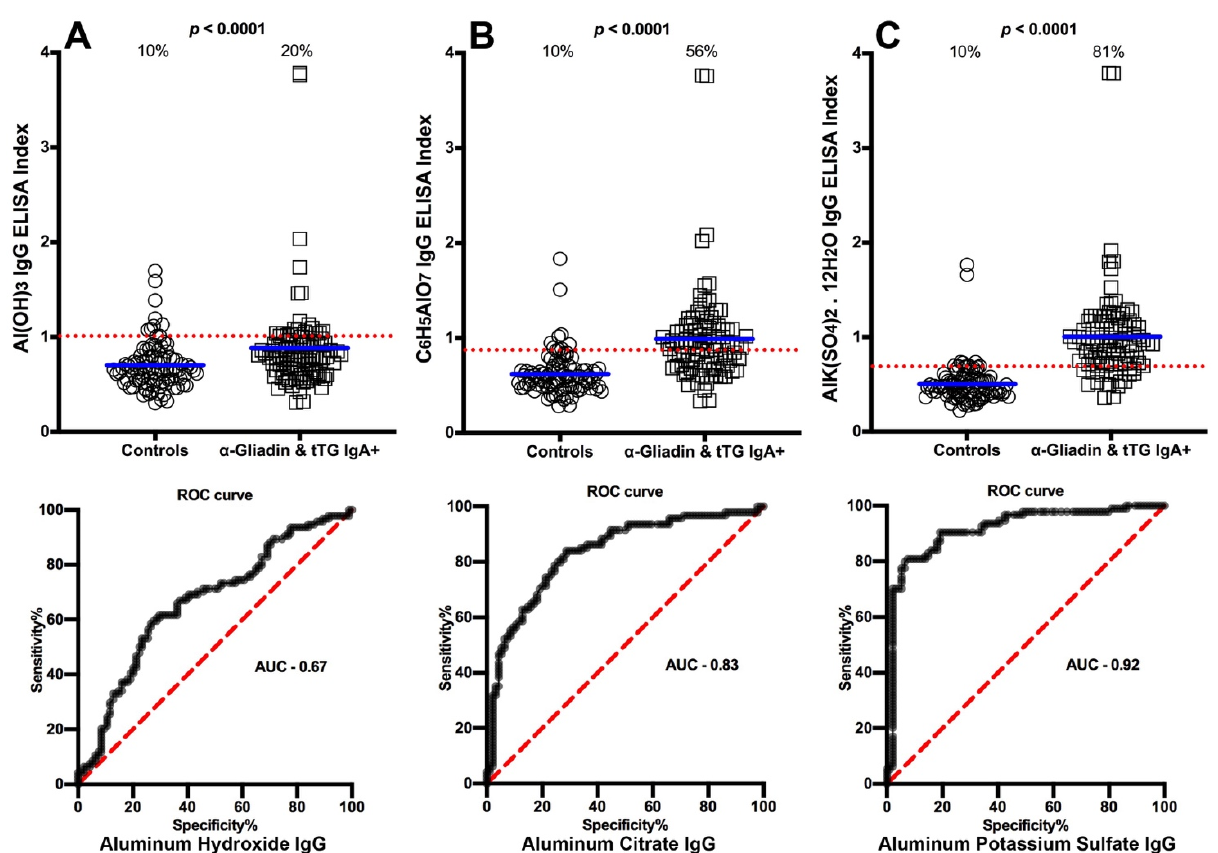
Figure 2. Percentages of samples with elevations in IgG antibodies against three different aluminum compounds in 94 healthy controls and 47 patients positive for gliadin 33-mer peptide and tTG (celiac disease). Dotted horizontal lines indicate the cutoff for positivity used in each assay, as calculated by receiver operating characteristic (ROC) analysis. The percentages of elevation, controls vs. patients, are indicated at the top of each distribution, while the thick short horizontal full bars indicate the respective means ( A ) The percentage of gliadin- and tTG-positive patients with elevated IgG antibodies against aluminum hydroxide was 20%, with an area under the curve (AUC) of 0.67; ( B ) The percentage of gliadin- and tTG-positive patients with elevated IgG antibodies against aluminum citrate was 56%, with an AUC of 0.83; ( C ) The percentage of gliadin- and tTG-positive patients with elevated IgG antibodies against aluminum potassium sulfate was 81%, with an AUC of 0.92.